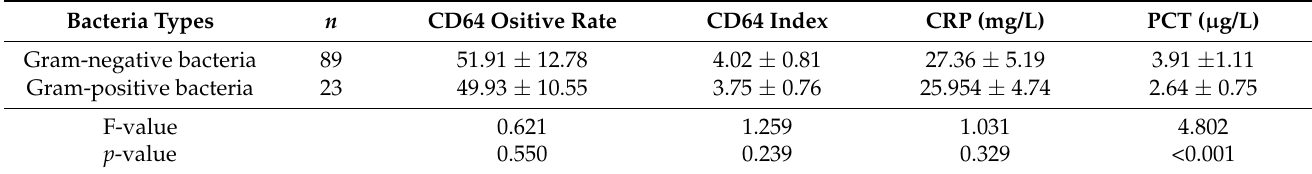
Table 3. Comparison of infection indexes between different bacterial infection groups.